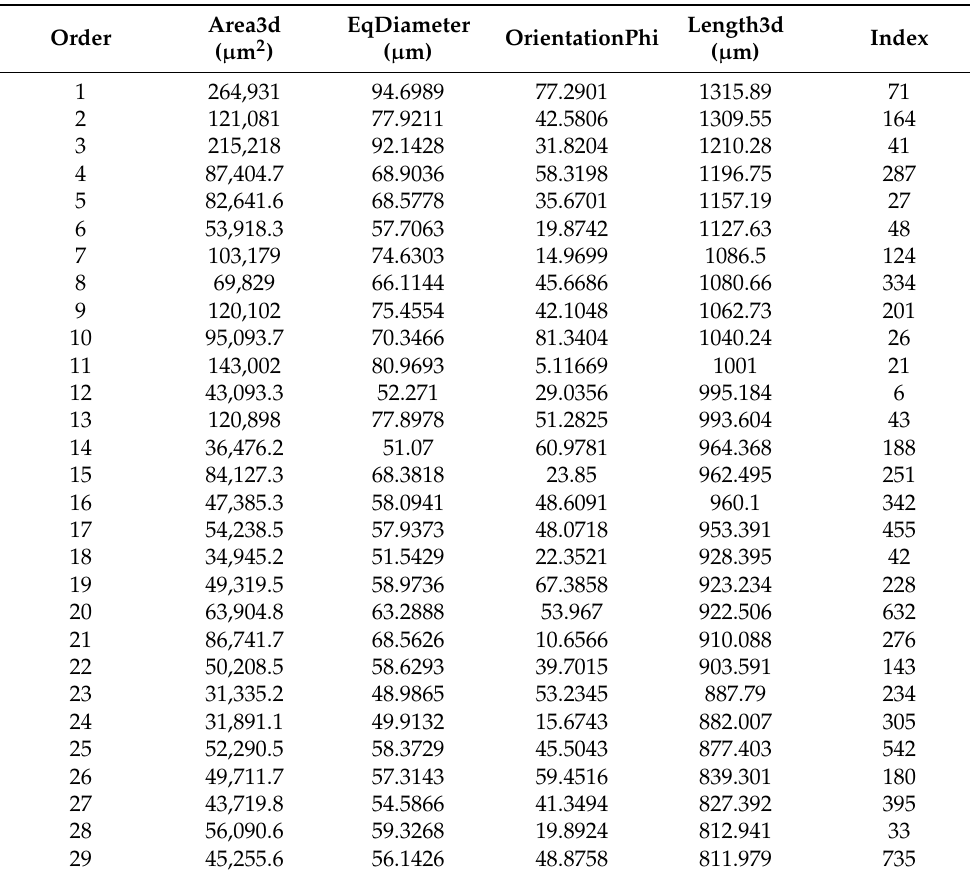
Table 1. A section of Excel of statistics of fibers in